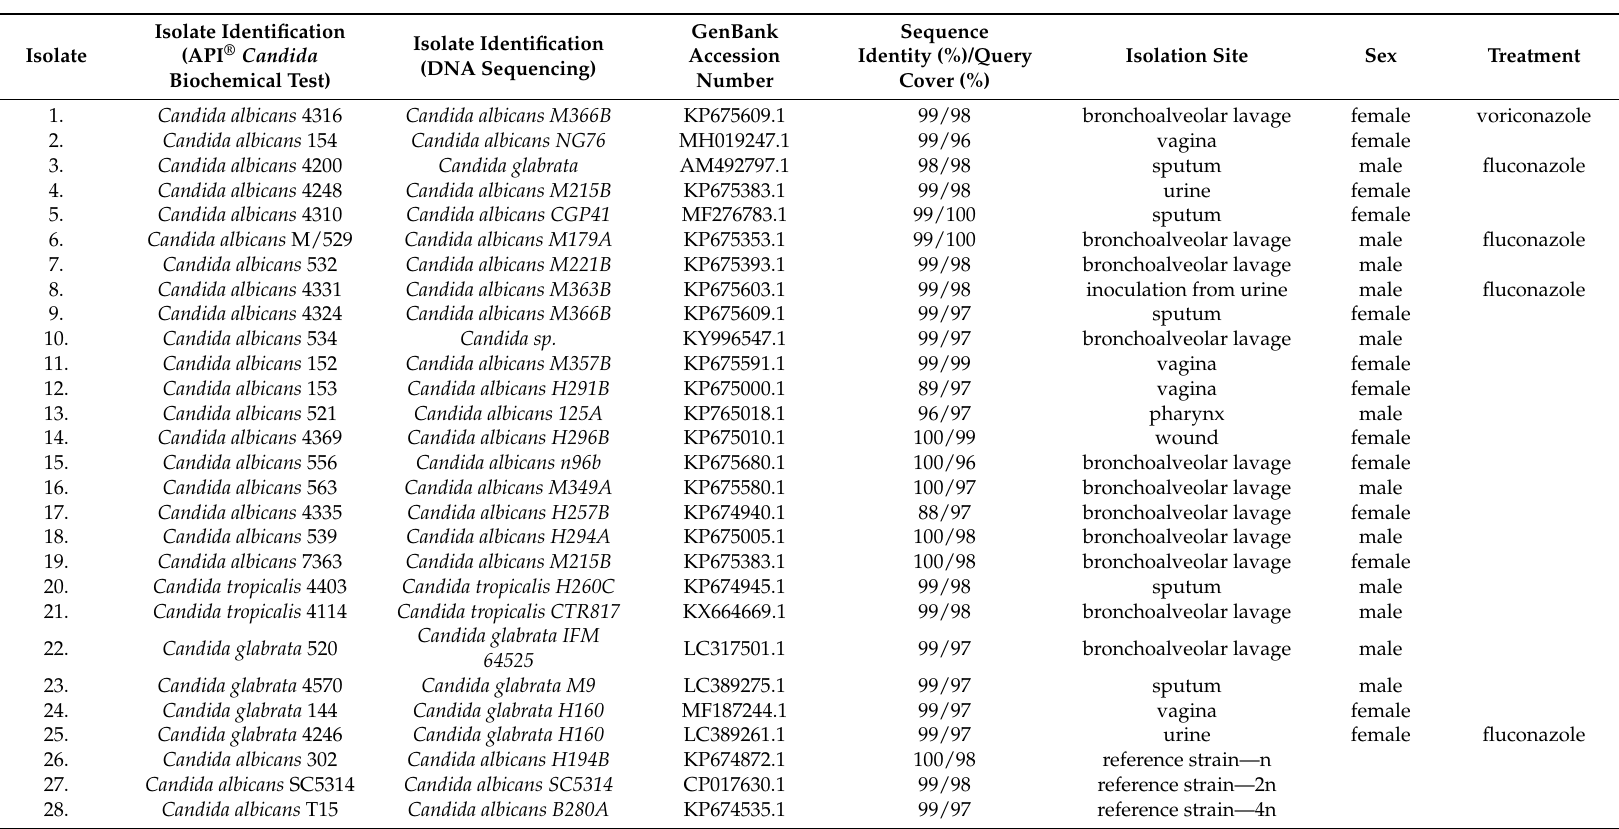
Table 1. Clinical Candida species isolates used in the present study. Three reference strains, namely haploid, diploid, and tetraploid strains were also considered.